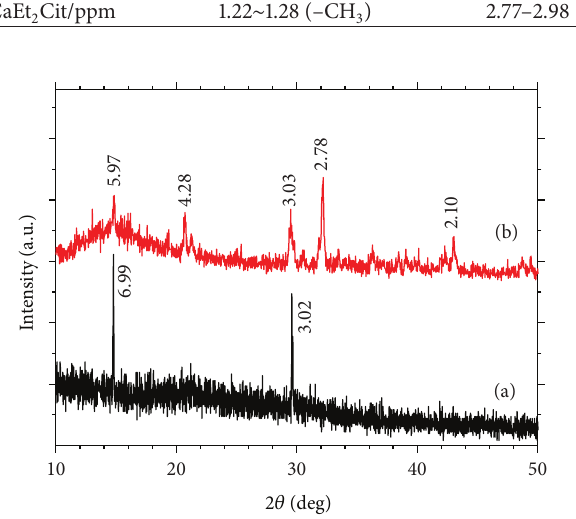
Figure 4: XRD patterns of CaEt 2 Cit and CaCl 2 : (a) CaEt 2 Cit and (b) CaCl 2 .